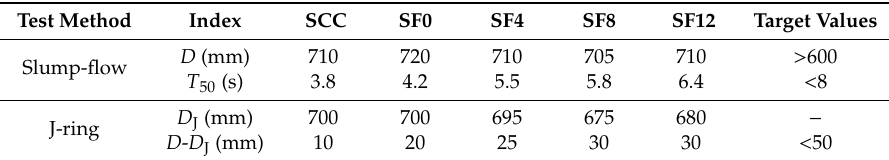
Table 5. Workability of self-compacting